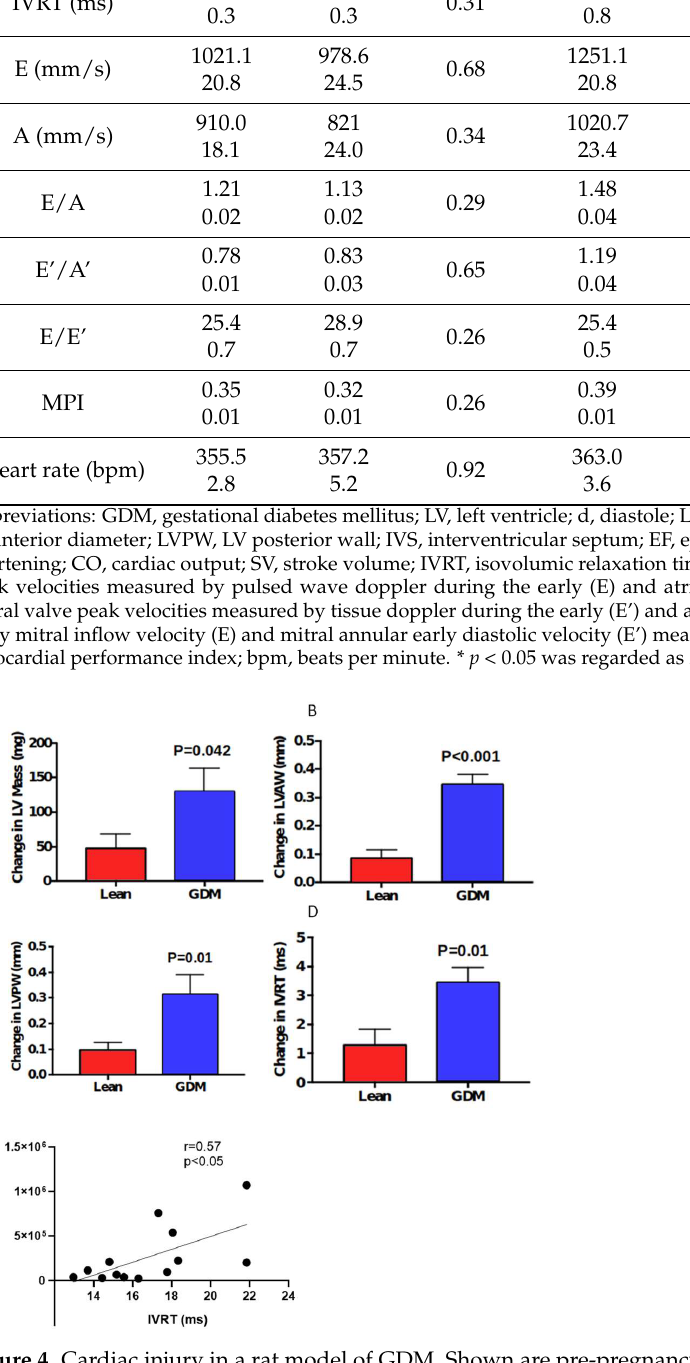
Figure 4. Cardiac injury in a rat model of GDM. Shown are pre-pregnancy to pregnancy changes in left ventricular (LV) mass ( A ), LV anterior wall thickness ( B ), LV posterior wall thickness ( C ), and isovolumetric relaxation time (IVRT D ). ( E ) Linear regression of association between endothelial EVs and IVRT.